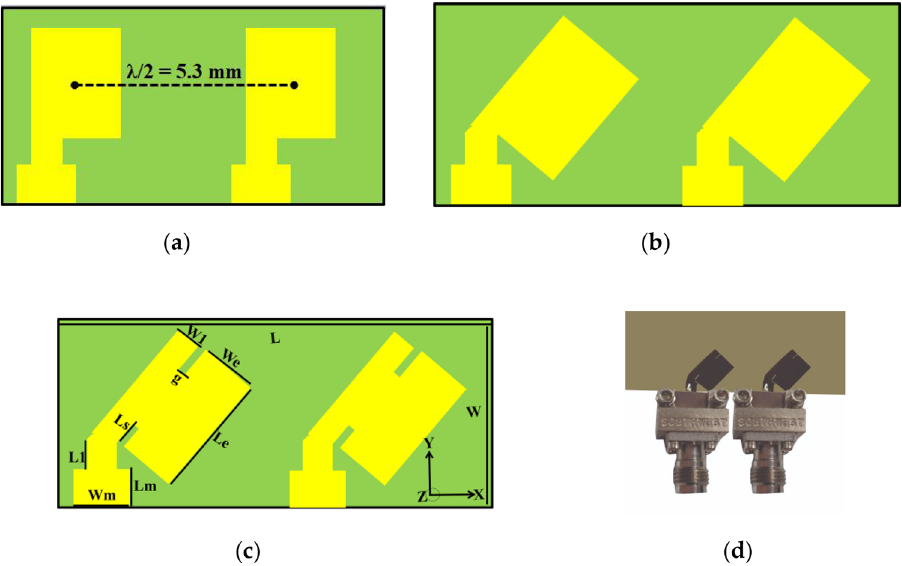
Figure 1. Design evolution of the proposed MIMO Antenna ( a ) Straight elements ( b ) Bend elements ( c ) Proposed ( d )